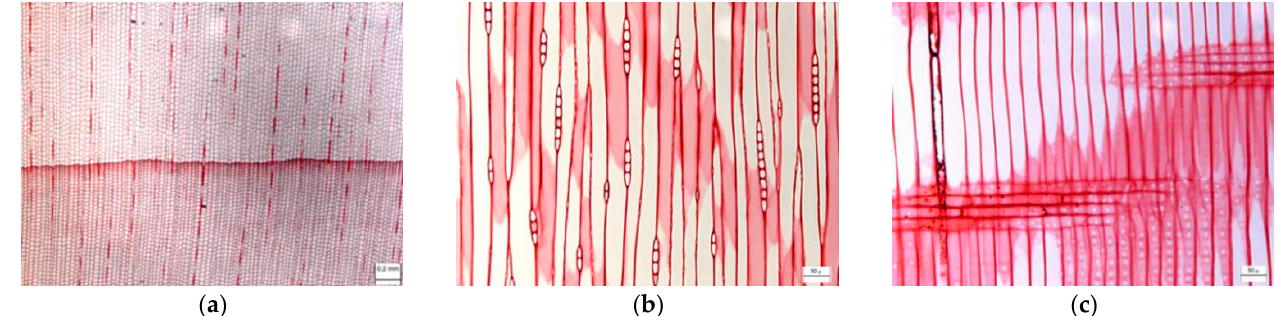
Figure 10. Micrograph of Chinese fir (by S. Lazzeri, CNR-IVALSA); ( a ) cross section; ( b ) tangential section; ( c ) radial section.